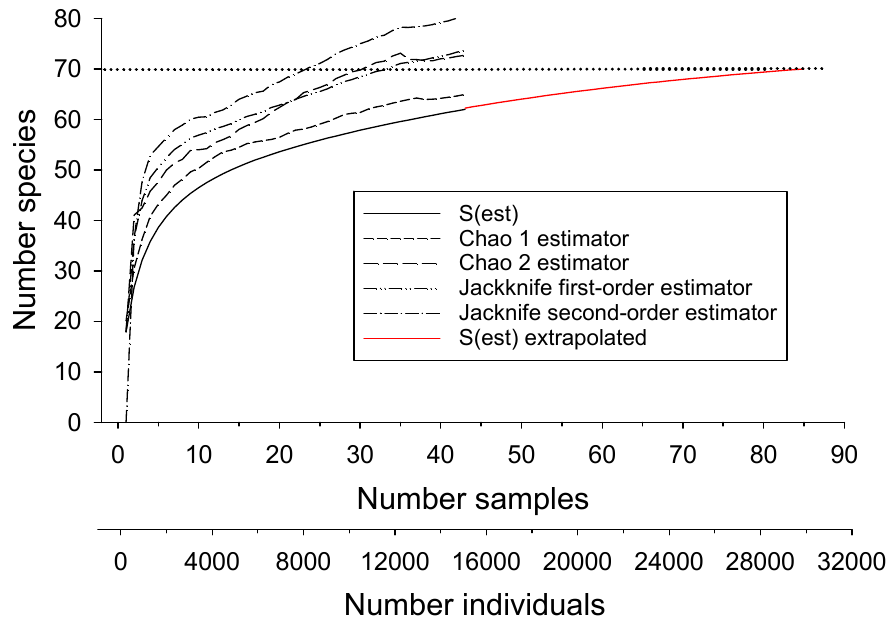
Figure 4. Performance of species richness estimators compared with the species accumulation curve [S(est)] for fish from collected from 32 sites selected based on a stratified sampling design. Also shown are the extrapolated number expected if additional samples had been collected. Dotted line represents best estimate of total species